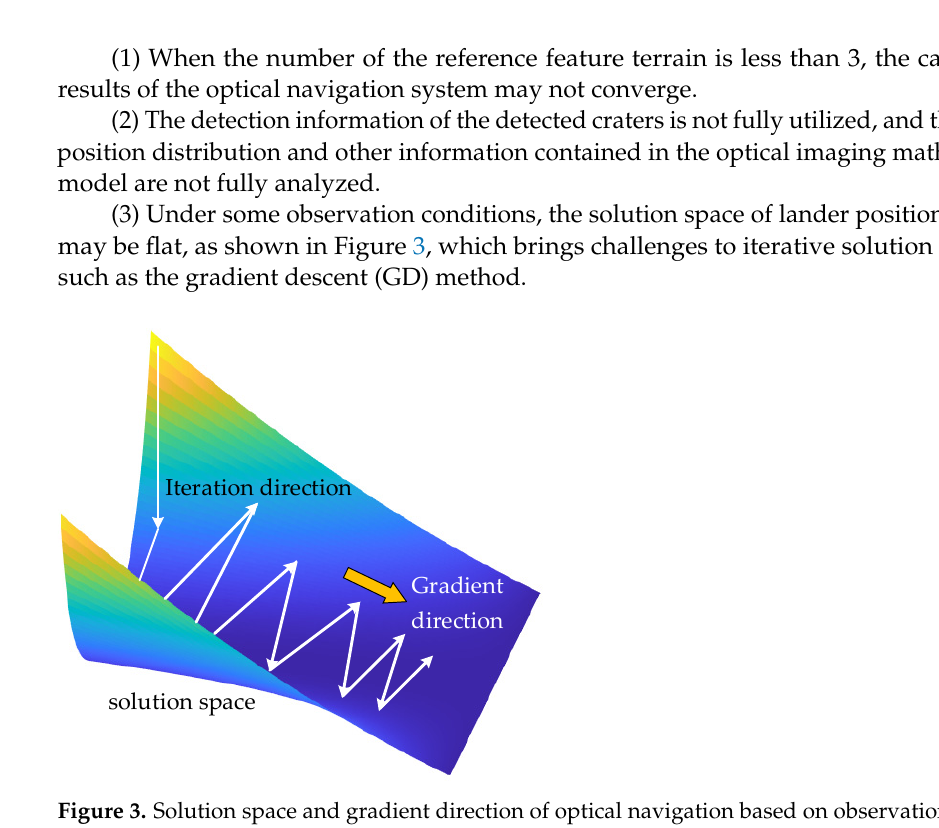
Figure 3. Solution space and gradient direction of optical navigation based on observation vector.